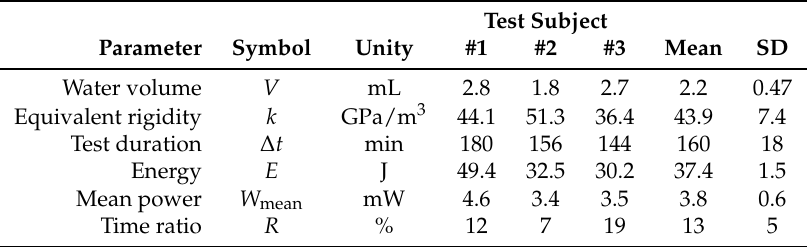
Table 2. Experimental results in